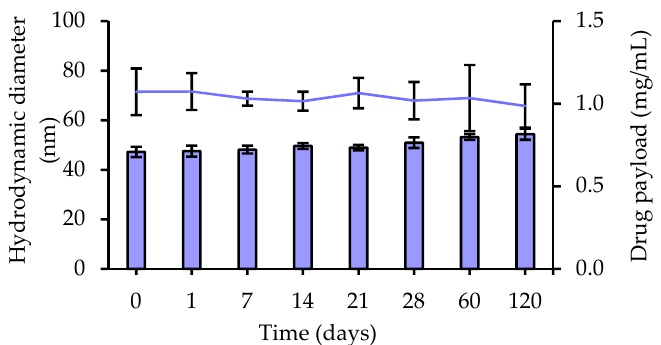
Figure 4. Stability of Tg-NEs estimated by the hydrodynamic diameter (bars) and the drug payload (line) during 120-day storage at 4 °C.